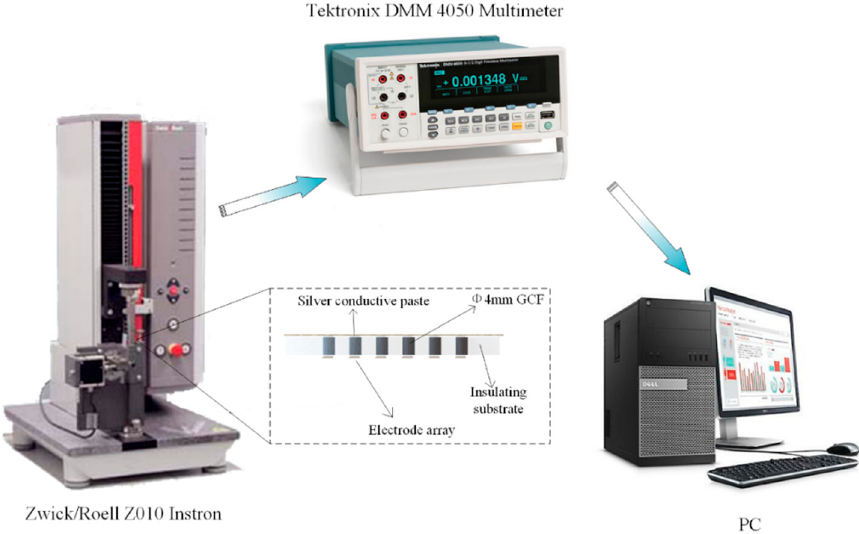
Figure 3. The measurement system.